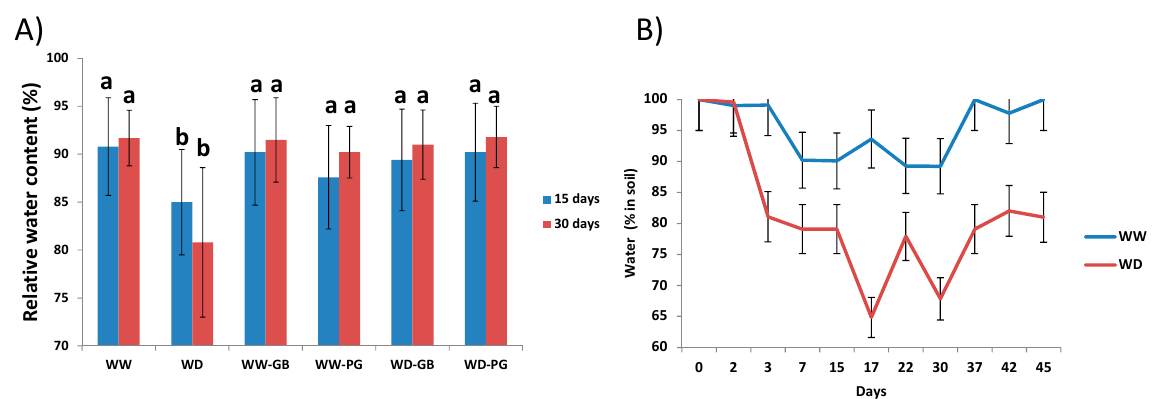
Figure 3. Plant water relations. ( A ) Relative water content. ( B ) Soil water content. Bars labelled with the same letter did not show significant differences at p < 0.05.